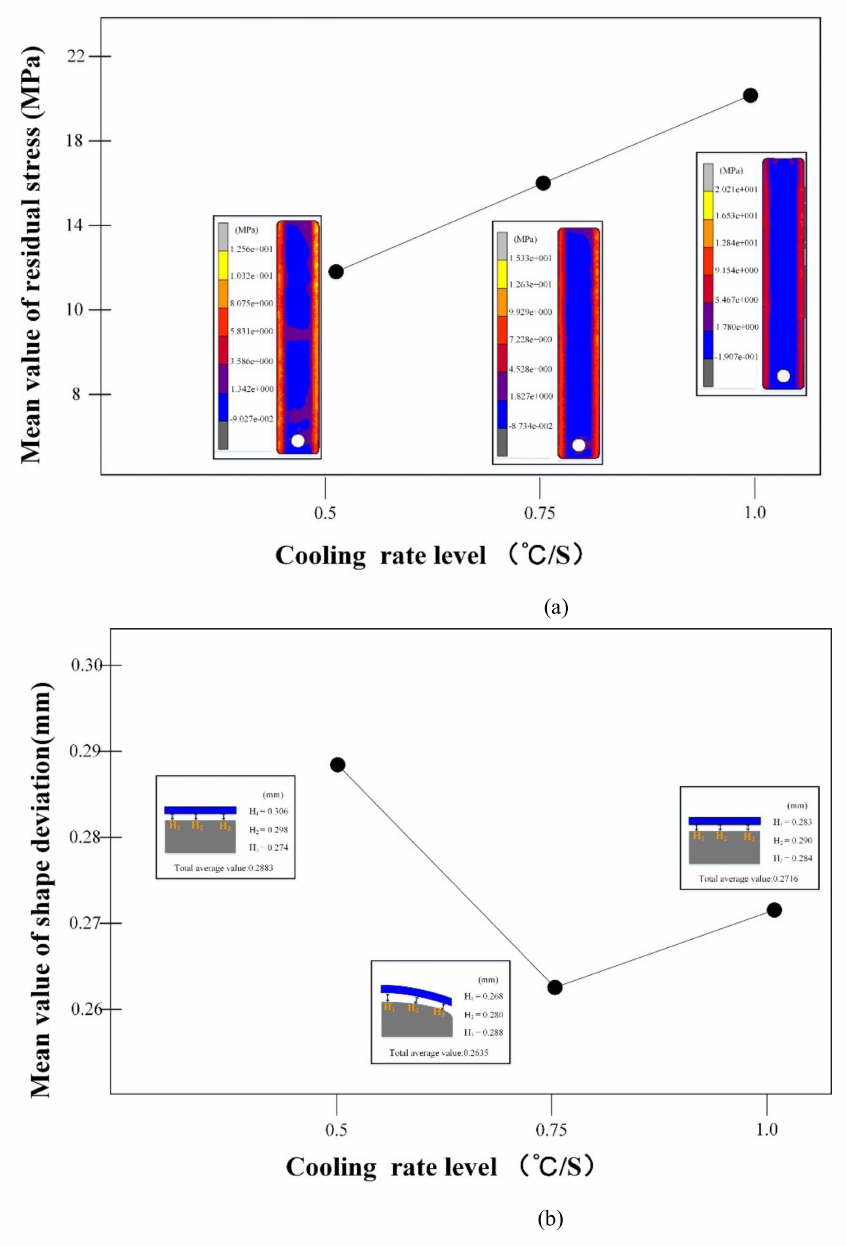
Figure 14. Effect of cooling rate on residual stress. ( a ) Effect of cooling rate on residual stress; ( b ) Effect of cooling rate on shape